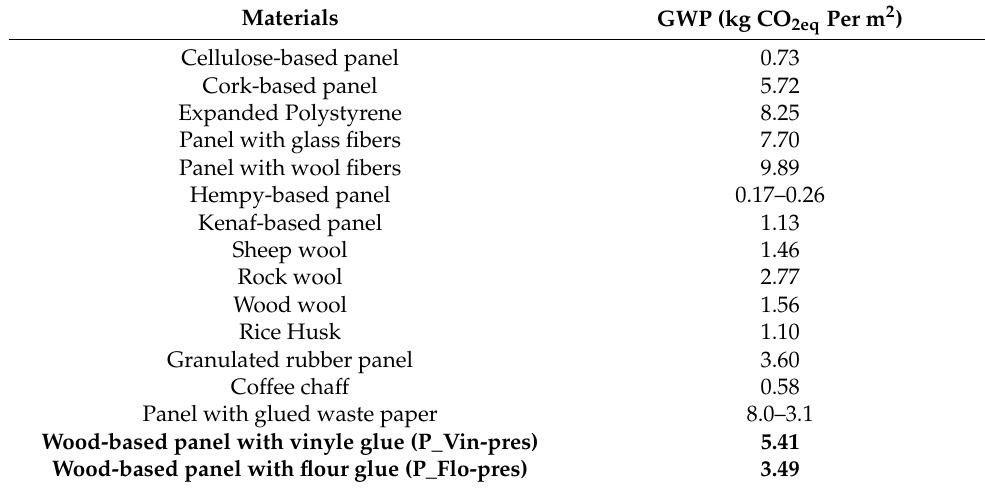
Table 3. Comparison between the global warming potential of different insulating materials (in bold data from the present